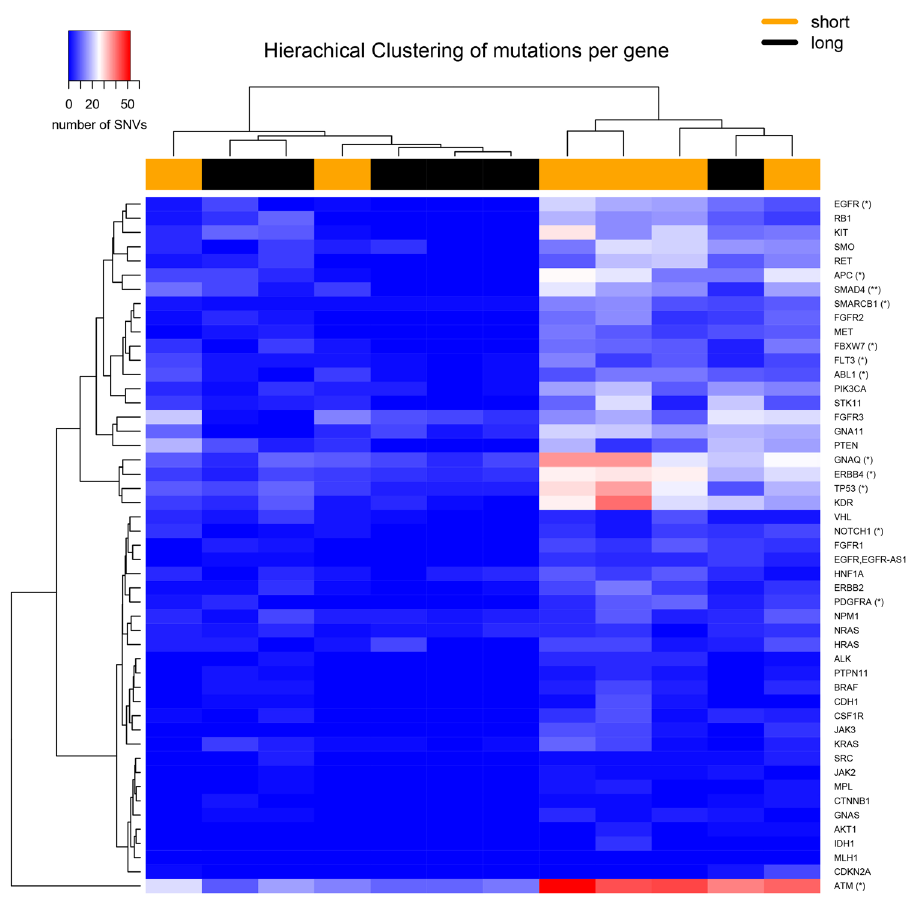
Figure 3. Heatmap of DNA mutations between short and long survivors in the cohort study. Mutations were summed up for each gene and hierarchical clustering performed. Significant genes of a Wilcox ranked sum test between long and short survival patients are indicated by having a p-value of ( * ) 0.05 and ( ** ) 0.01 (not